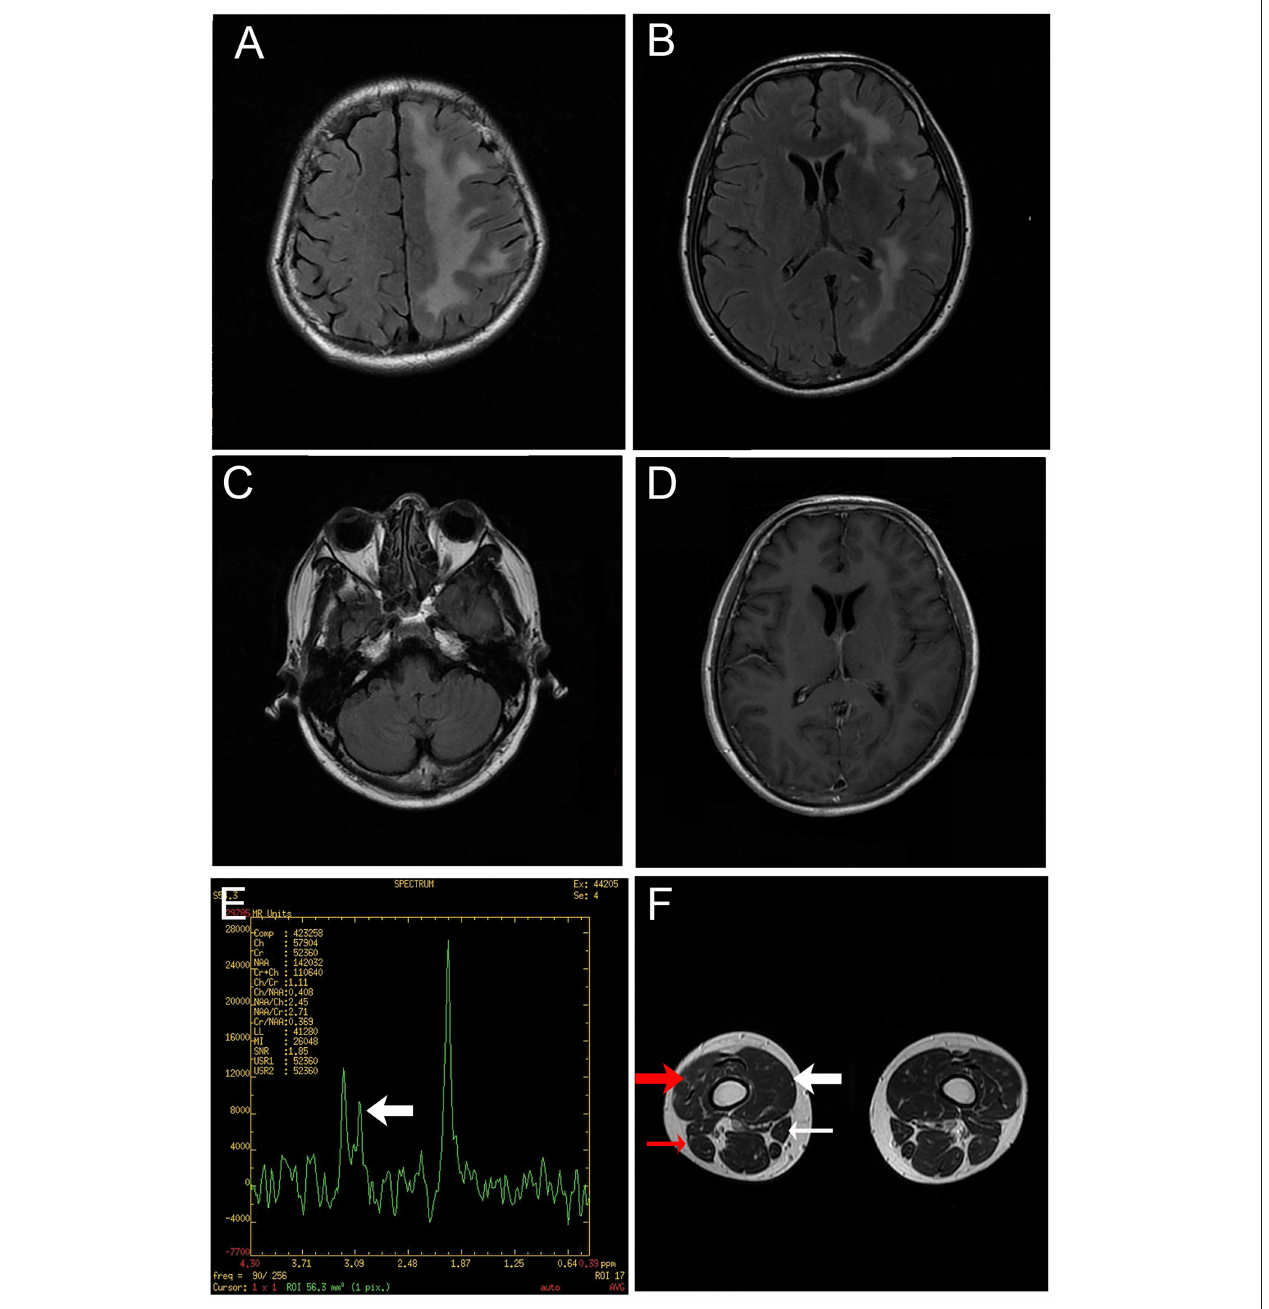
FIGURE 2 | Magnetic resonance images. (A – C) T2-weighted fluid-attenuated inversion recovery images of the brain depicting diffuse hyperintensity signals in the left cerebrum. (D) Gadolinium enhanced T1-weighted image showing no enhancement of the lesion. (E) Hydrogen magnetic resonance spectroscopy image of a lesion in the left cerebrum, including a decreased choline peak (arrow). (F) Magnetic resonance image of the legs revealing muscular atrophy of the right leg, particularly the vastus medialis (thick white arrow), vastus intermedius (thick red arrow), sartorius (thin white arrow) and biceps femoris (thin red arrow).